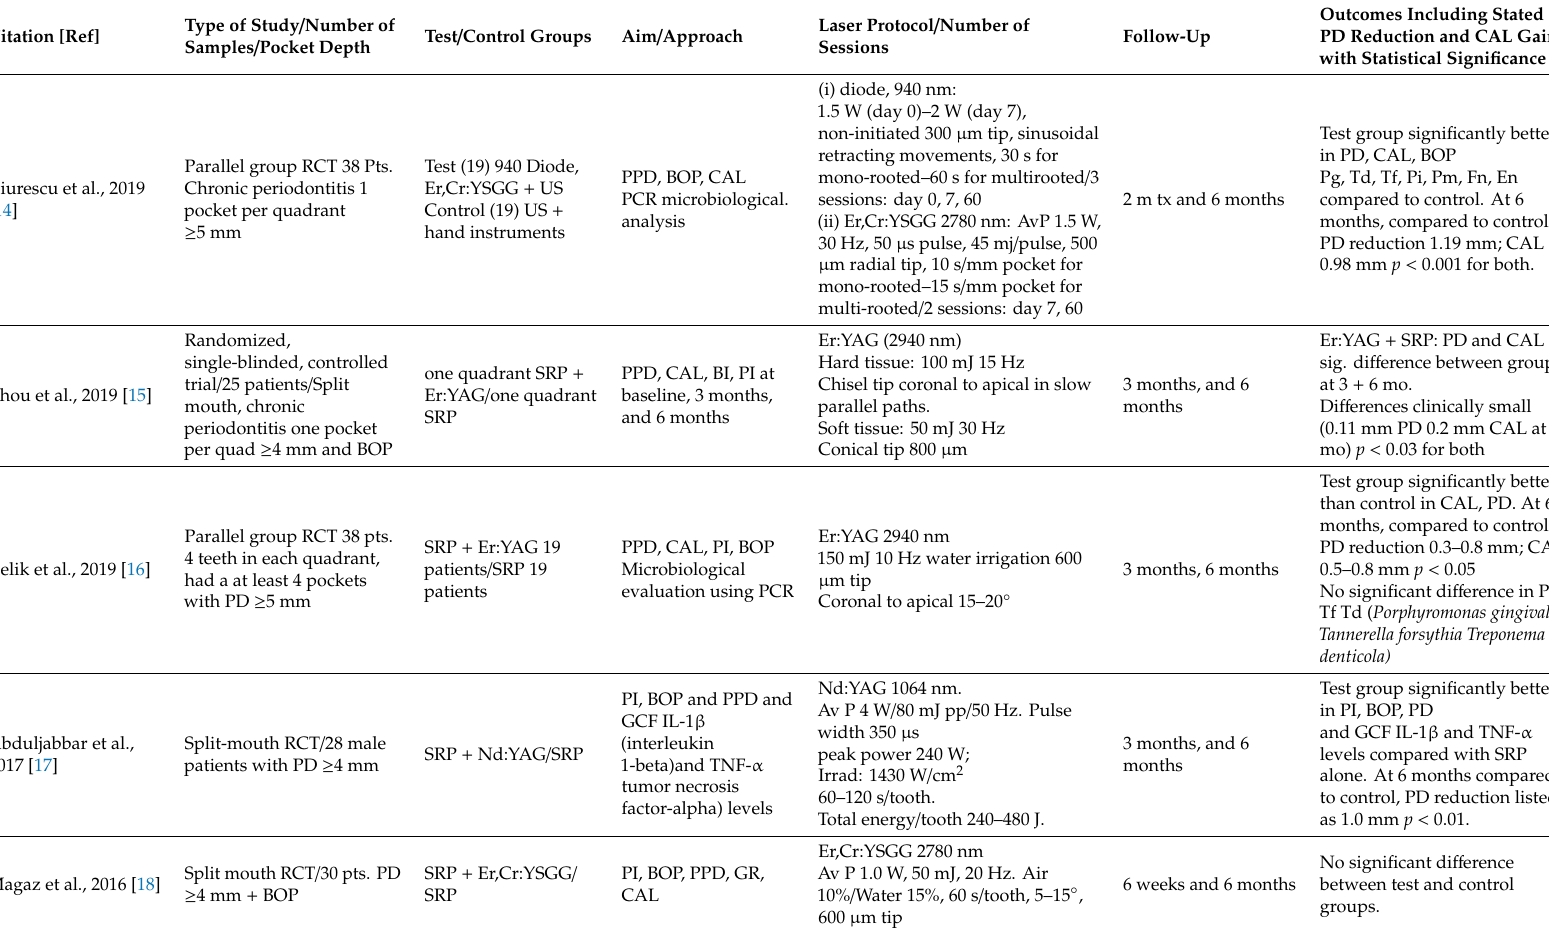
Table 1. The results of the search showing the primary author and citation; the type of study / number of samples / pocket depth; test / control groups; examined parameters; laser protocol / number of sessions; follow up period; and